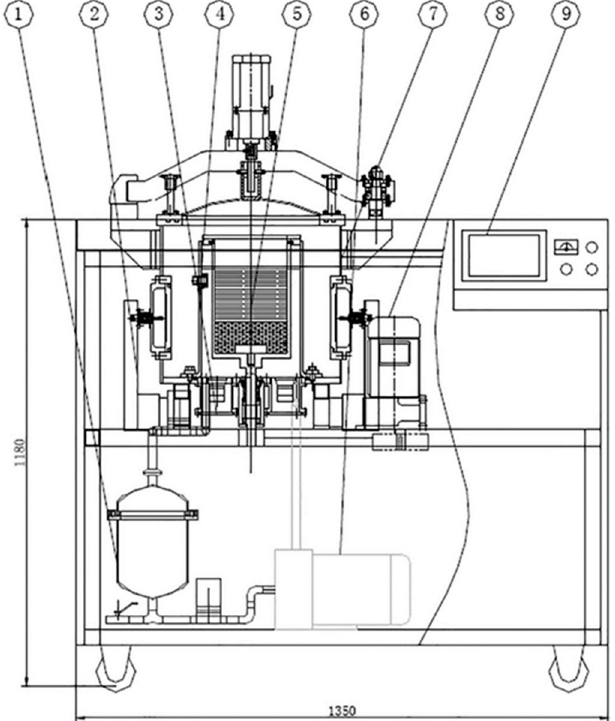
Figure 4. Schematic diagram of the combined ultrasonic-microwave-assisted vacuum frying (US- MVF) instrument: (1) Oil tank; (2) microwave source and heating system; (3) ultrasound source and vacuum pressure balance system; (4) vacuum chamber; (5) frying chamber; (6) circulation pump; (7) electric cabin door system; (8) blending and centrifugation system; and (9) controller and operation panel [45].